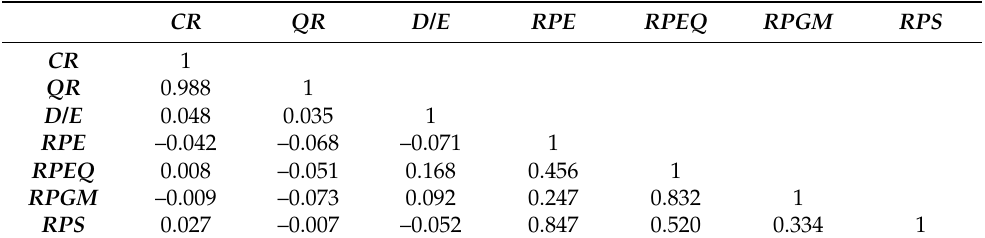
Table 8. Correlation matrix for oil companies.